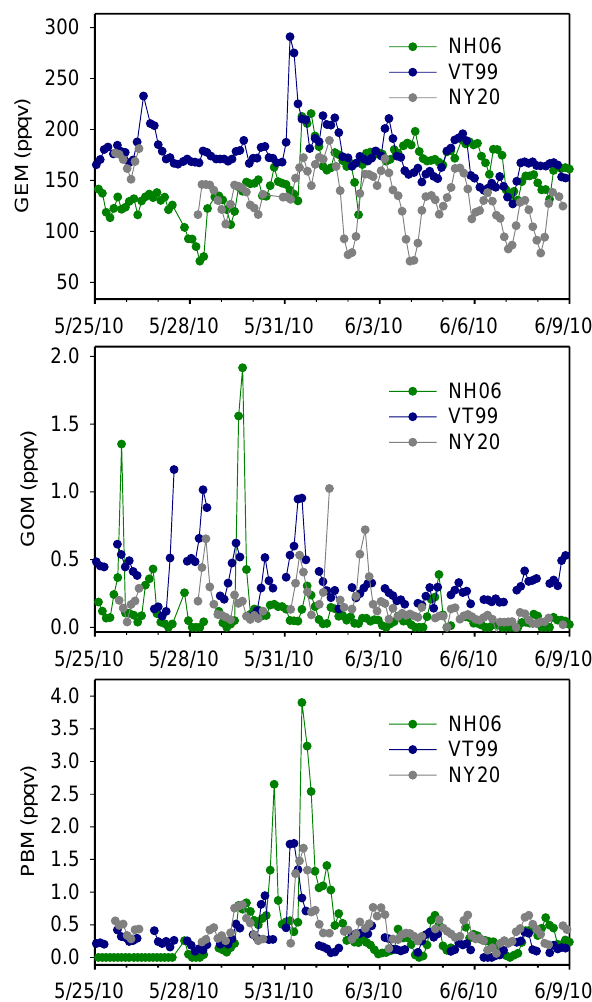
Fig. 4. Speciated mercury mixing ratios during the 2010 spring Quebec fire Figure 4. Speciated mercury mixing ratios during the 2010 spring Quebec fire event.